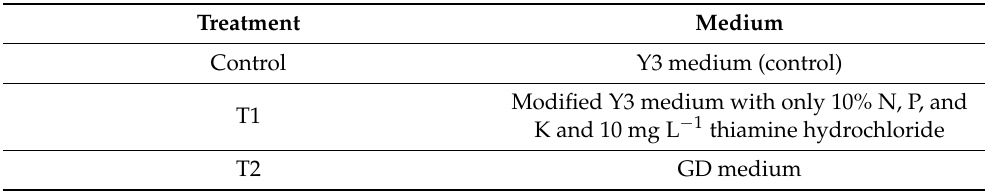
Table 6. Testing of different treatments using Eeuwens Y3 medium, modified Eeuwens Y3 medium, or Gresshoff and Doy (GD) medium to induce friable EC.